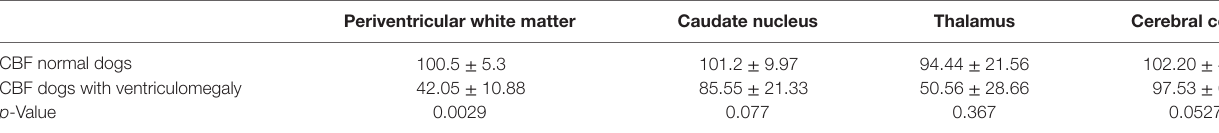
TaBle 1 | Mean ± SD quantitative estimates of CBF for the regions of interest evaluated in normal Cavalier King Charles spaniels and dogs with ventriculomegaly.